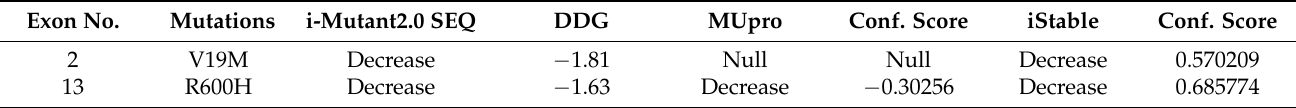
Table 2. Classification of two candidate deleterious missense mutations in the catalytic site of GAA protein using iStable server.